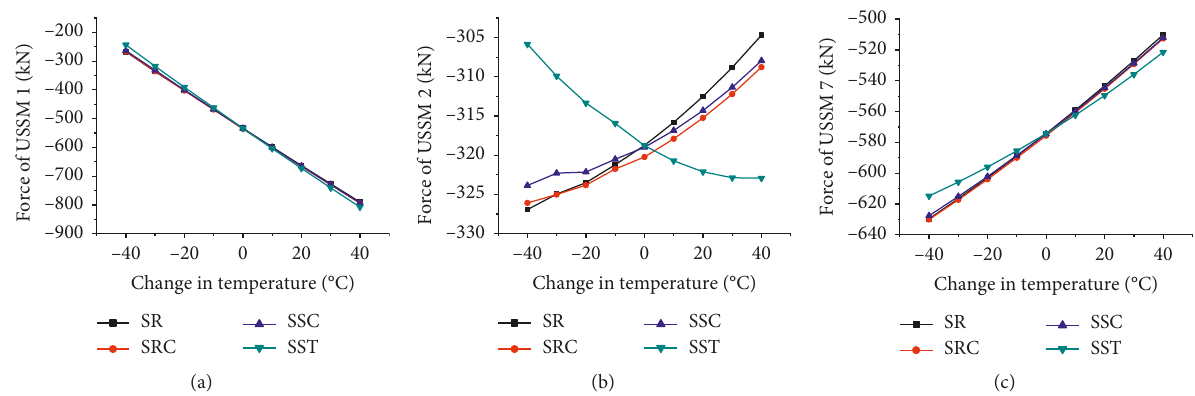
Figure 12: Relationship between the force of upper structural steel members and the temperature in the half-span load distribution. Change in the force of (a) USSM 1, (b) USSM 2, and (c) USSM 7 with varying temperature.